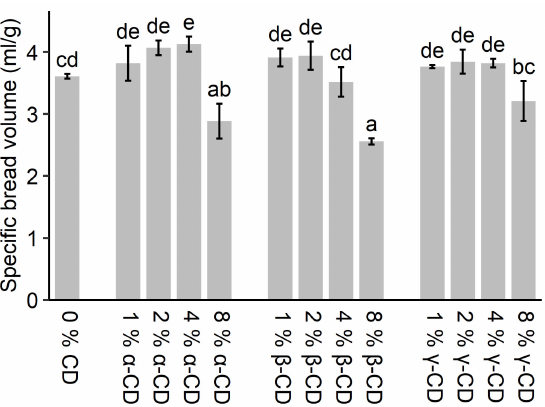
Figure 3. Specific bread volume for wheat bread with the addition of different types and concentra- tions of CD (Breadmaking I). The error bars indicate the standard deviation. Different letters indicate the significant difference between the treatments ( p <